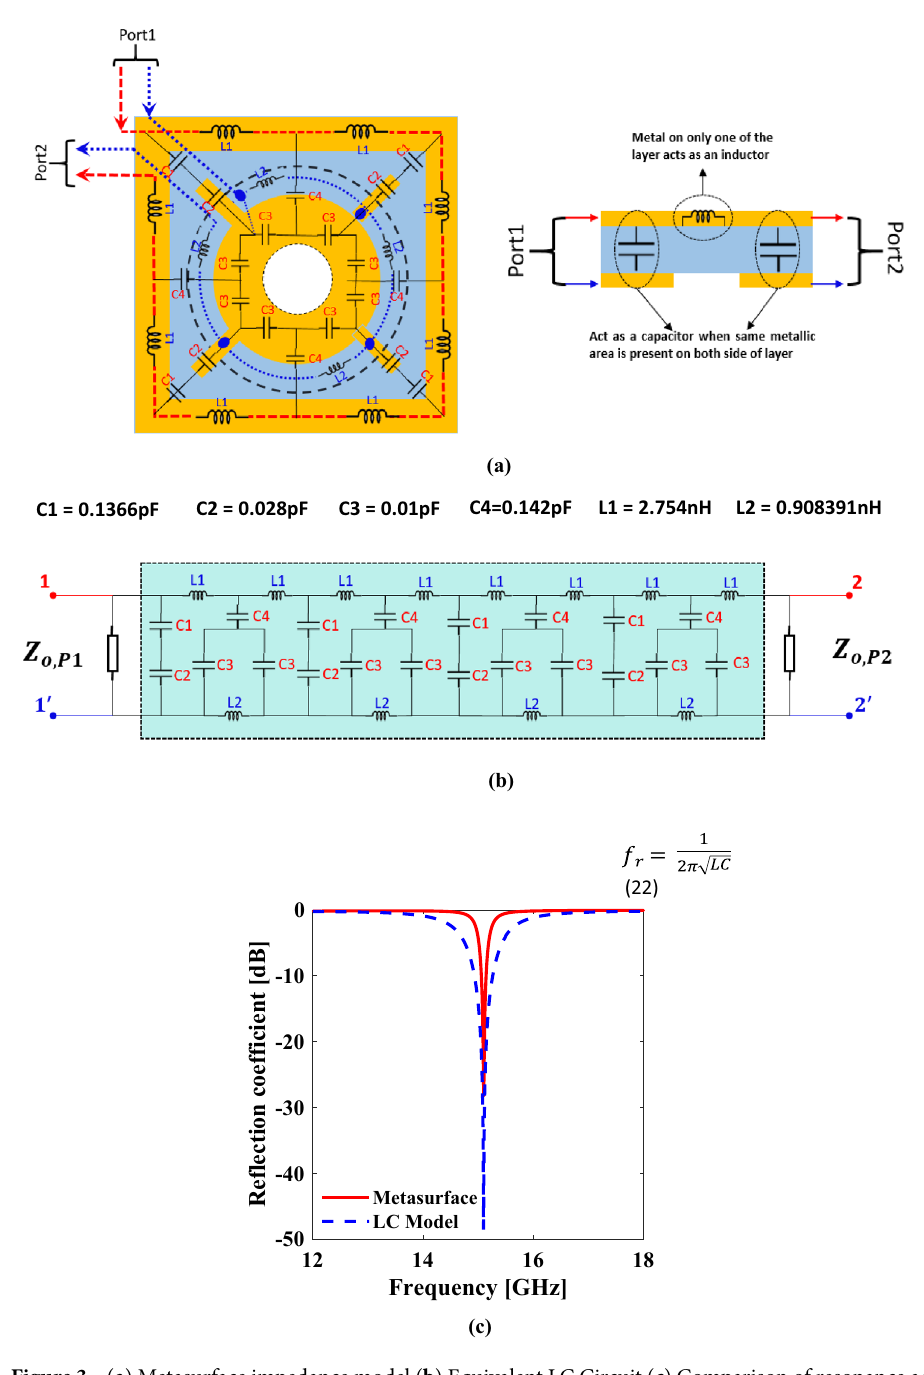
respectively 36 . This equivalent circuit is simulated using a circuit simulator namely Advanced Design System (ADS). From Fig. 3c, it can be deduced that the LC model and the metasurface resonate at a similar frequency i.e.15.1 GHz. Moreover, this resonance frequency can be tuned by tuning the capacitive and inductive area of the proposed unit cell using the following equation: